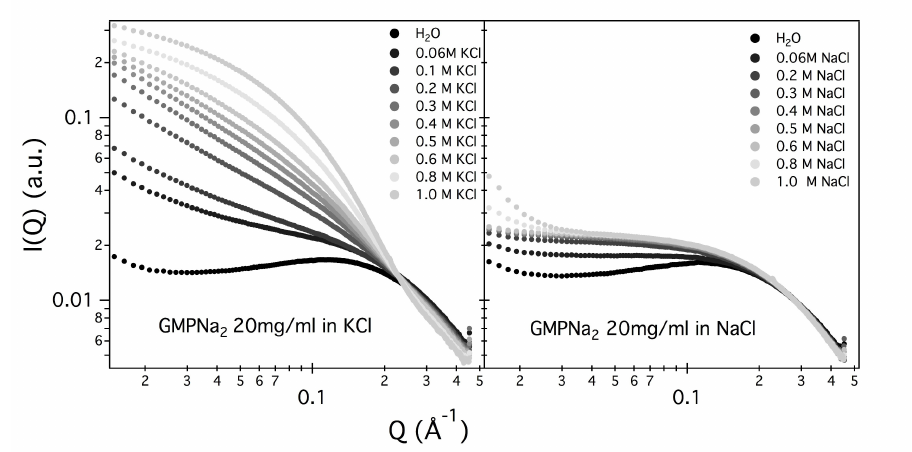
Figure 5. Comparison of SAXS profiles for GMPNa 2 , 20 mg/mL, in KCl and NaCl